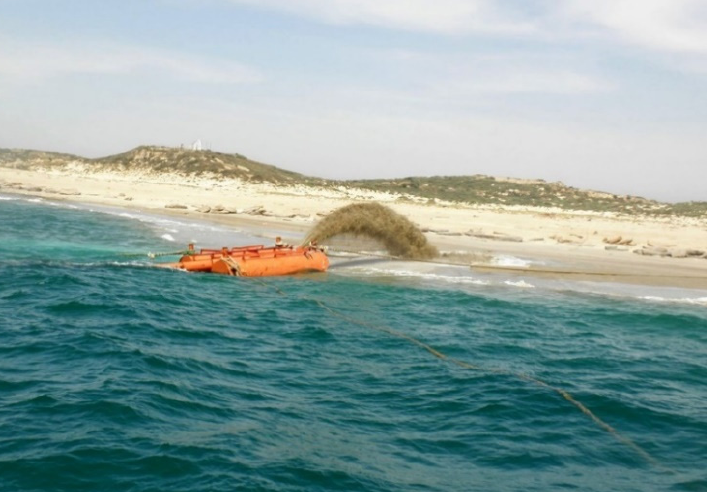
Figure 12. Nourishment rainbowing operation via discharge pipe. North of Ashdod Port, May–August 2011 (photograph by EDT Marine Construction).